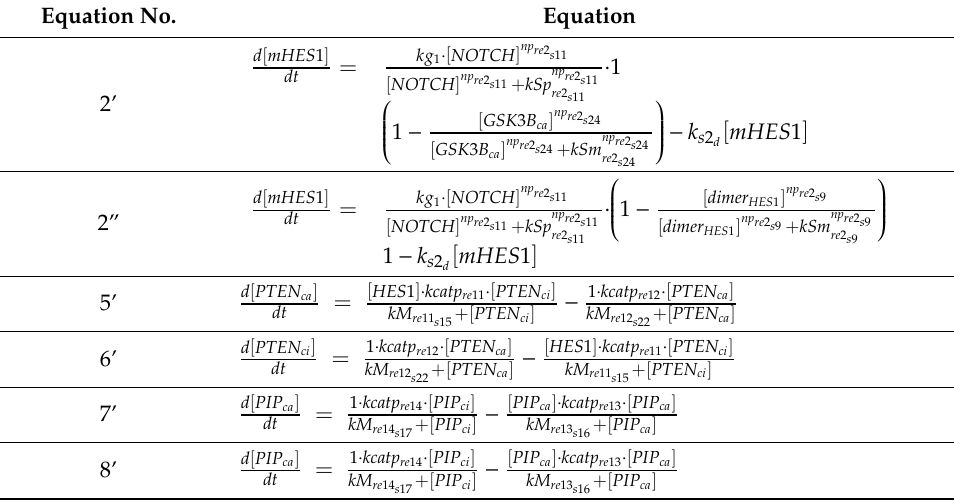
Table 4. Di ff erential equations of models with the feedback loop